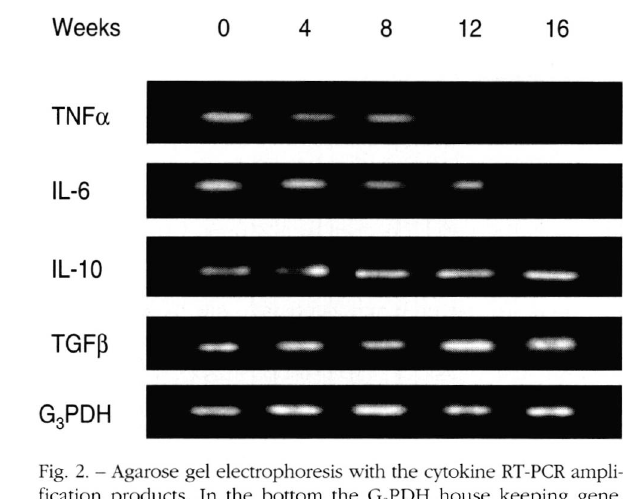
Fig. 2. - Agarose gel electrophoresis with the cytokine RT-PCR ampli­ fication products. In the bottom the G,PDH house keeping gene, above a representative panel of cytokines showing a progressive down-regulation of TNFa and IL-6 and up-regulation of IL-10 and TGFfβ